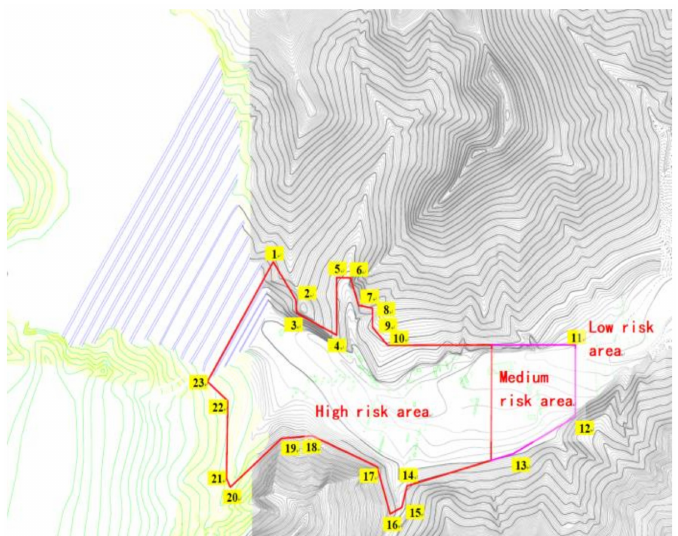
Figure 19. Dam failure risk prevention and control